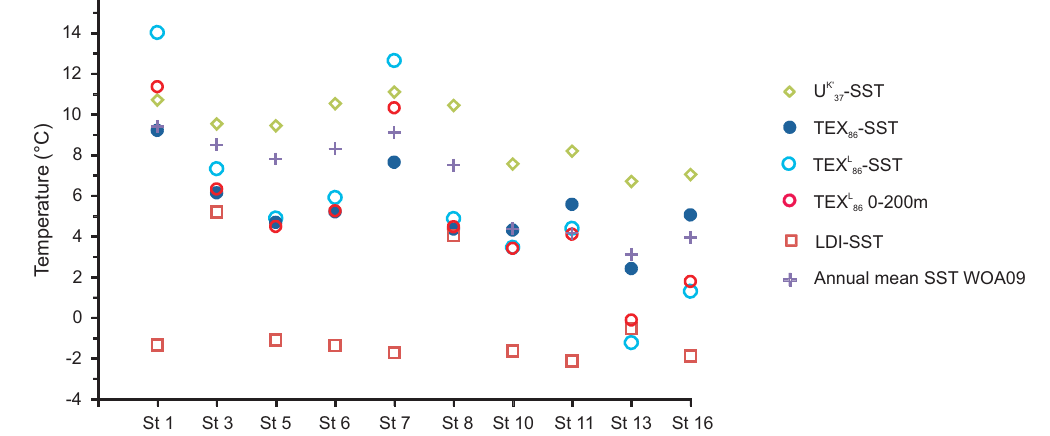
(cid:48) (open green diamonds), TEX 86 (dark blue circles), 37